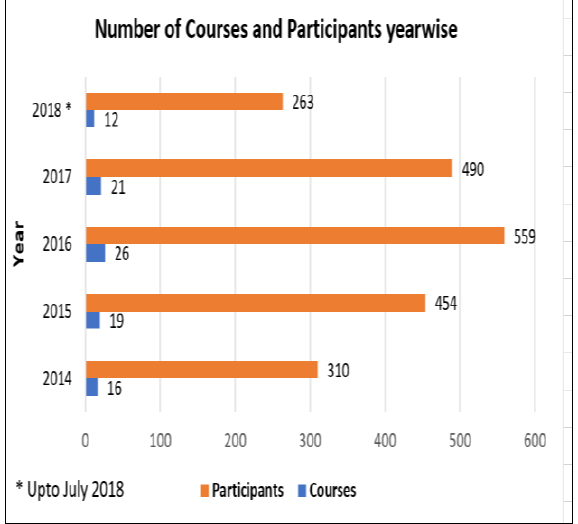
Fig 3. Year wise courses conducted and